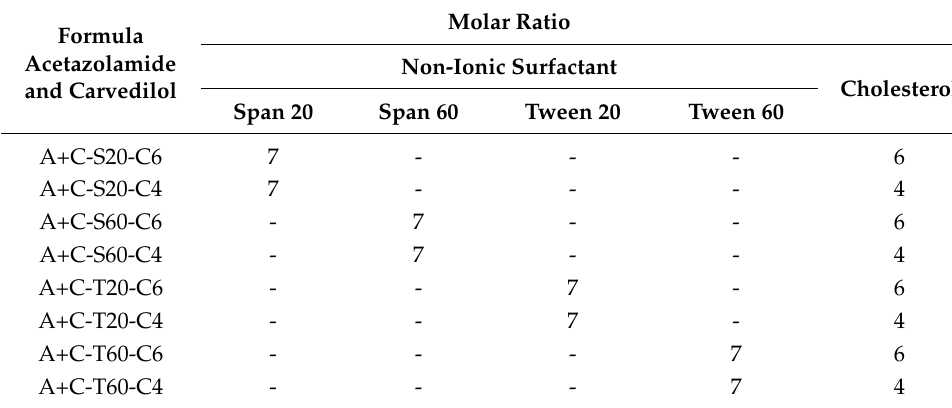
Table 2. Composition of combination niosomes formulations, n =